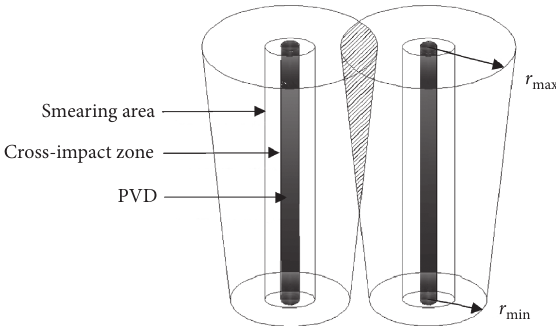
Figure 11: Sphere of influence of a single